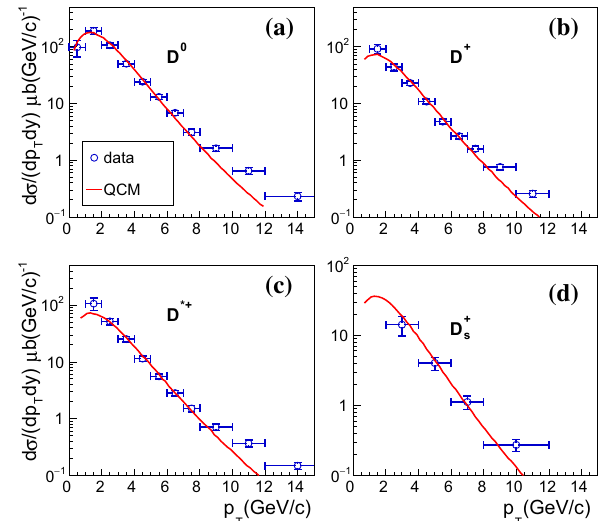
Fig. 2 Differential cross-sections of D mesons at mid-rapidity as the √ s = 7 TeV. Symbols are experi- function of p T in pp collisions at mental data [40] and lines are results of